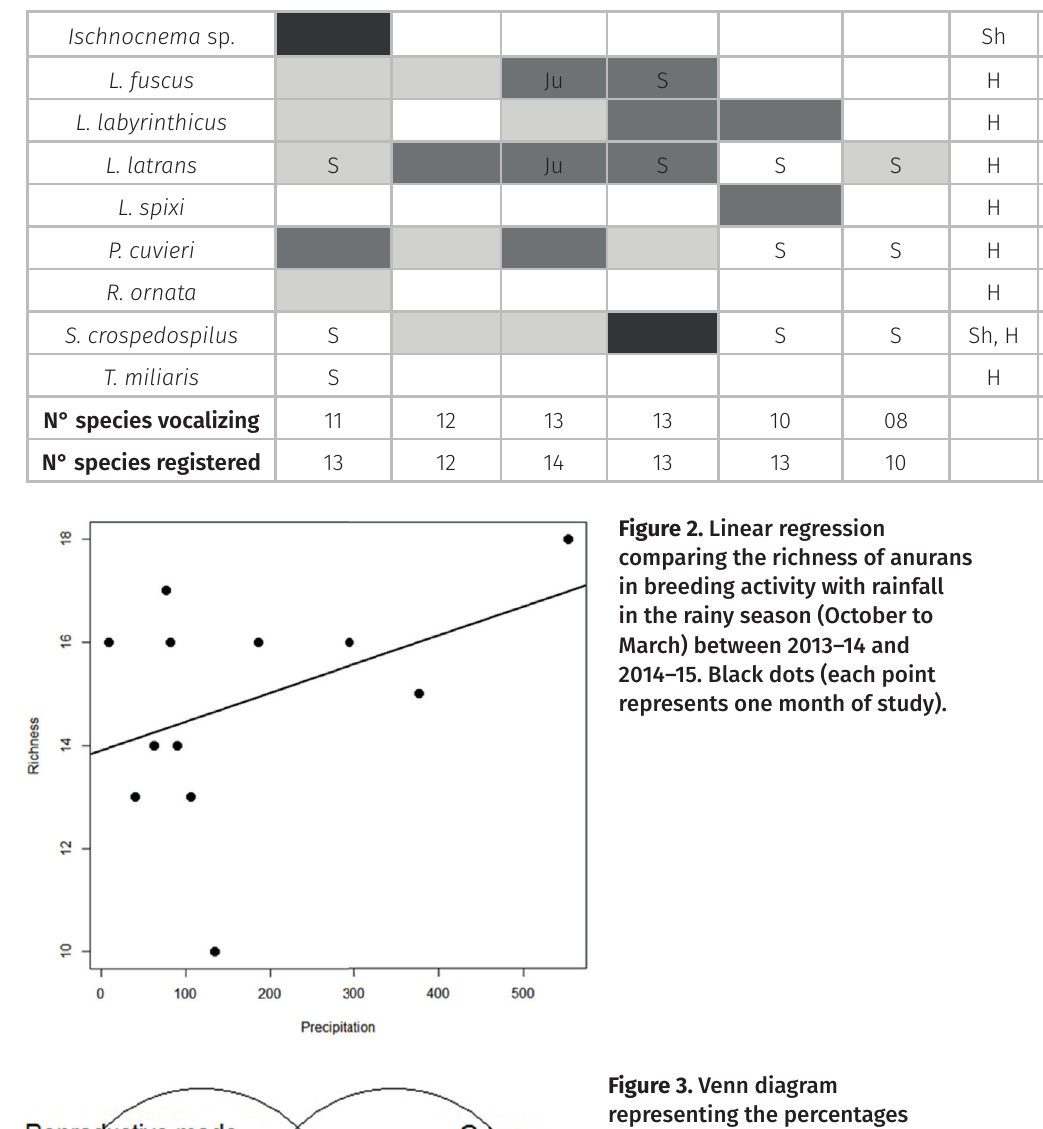
Figure 3. Venn diagram representing the percentages of each signifi cant explanatory variable and the correlation between them based on the spatial organization of species composition in habitats in the Municipality of Barão de Monte Alto, State of Minas Gerais,